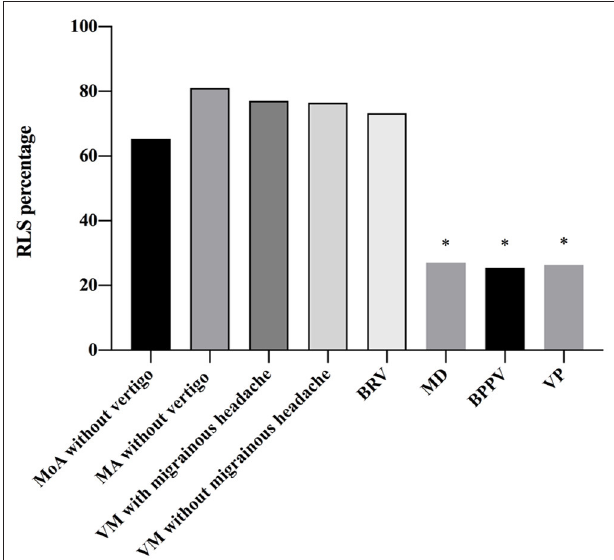
FIGURE 2 | Frequency of right-to-left shunt (RLS) in patients with different diseases. There is a statistical difference between the frequency of RLS in patients with benign recurrent vertigo (BRV) and that in patients with Meniere’s disease (MD), benign paroxysmal positional vertigo (BPPV), and vestibular paroxysmia (VP). The proportion of RLS in patients with BRV is significantly higher than that in patients with MD, BPPV, and VP ( P < 0.05). The proportion of RLS in patients vestibular migraine (VM) with and without migrainous headaches is also significantly higher than that in patients with MD, BPPV, and VP ( P < 0.05). However, there is no statistical difference between the frequency of RLS in patients with BRV and that in migraine without aura ( P = 0.931), MA ( P = 0.997), VM with migrainous headache ( P = 0.787), and VM without migrainous headache ( P = 0.754). BPPV, benign paroxysmal positional vertigo; BRV, benign recurrent vertigo; MA, migraine with aura; MD, Meniere’s disease; MoA, migraine without aura; RLS, right-to-left shunt;